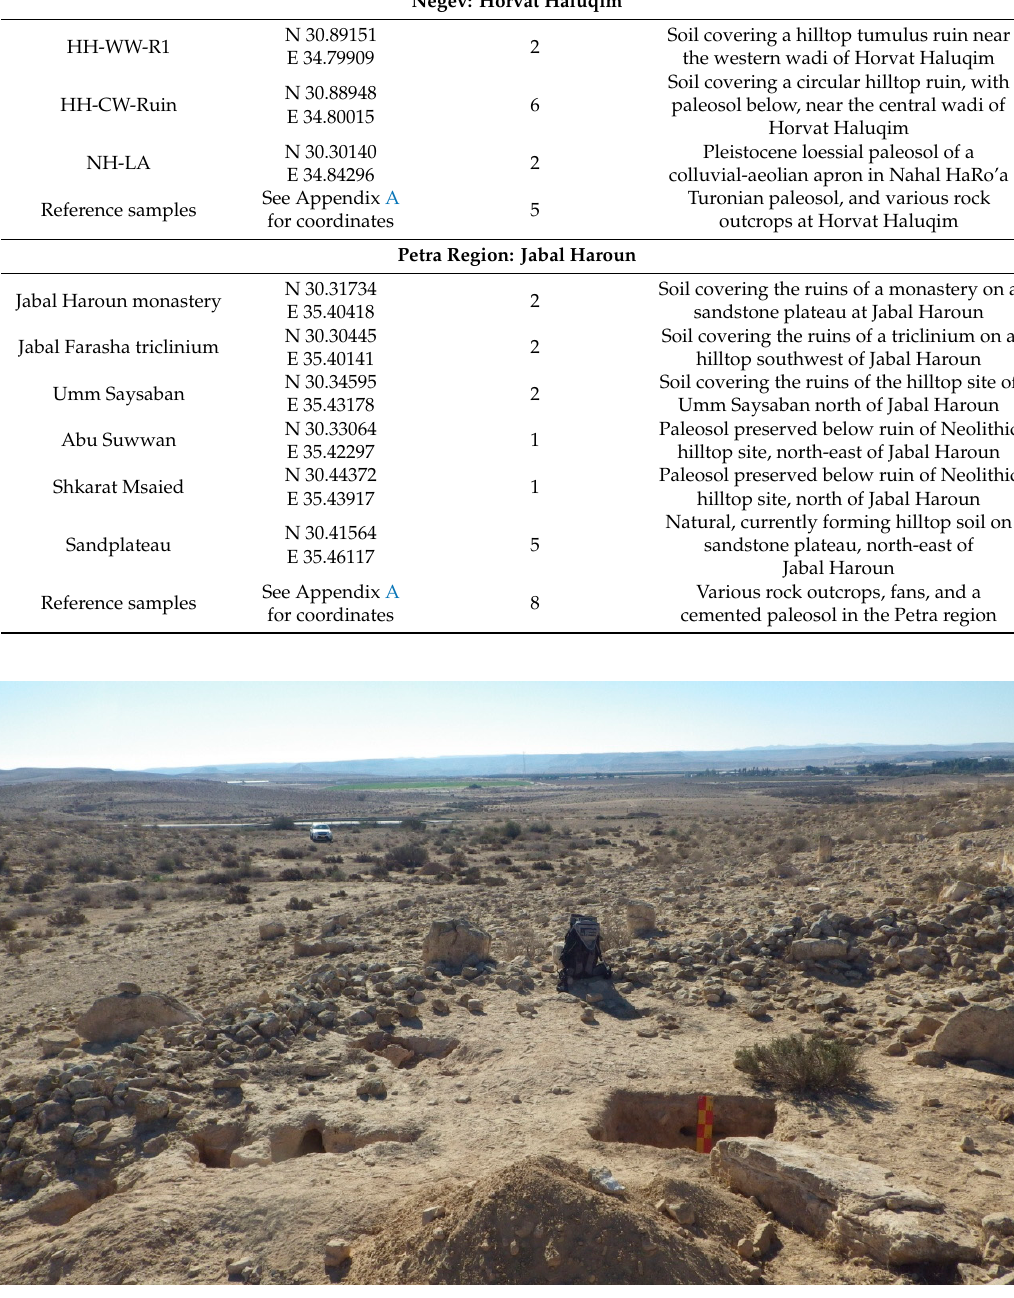
Figure 3. View from the top of Jabal Haroun to the south-west. The excavated ruins of the monastery of Jabal Haroun are visible in the center of the image and the Wadi Araba/Arava valley is in the background.